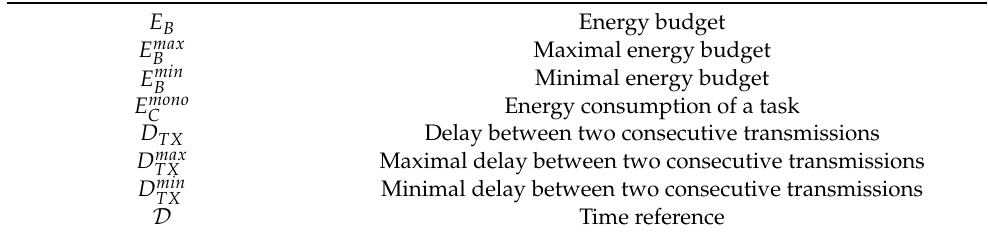
Table 1. Table of Notation—Section